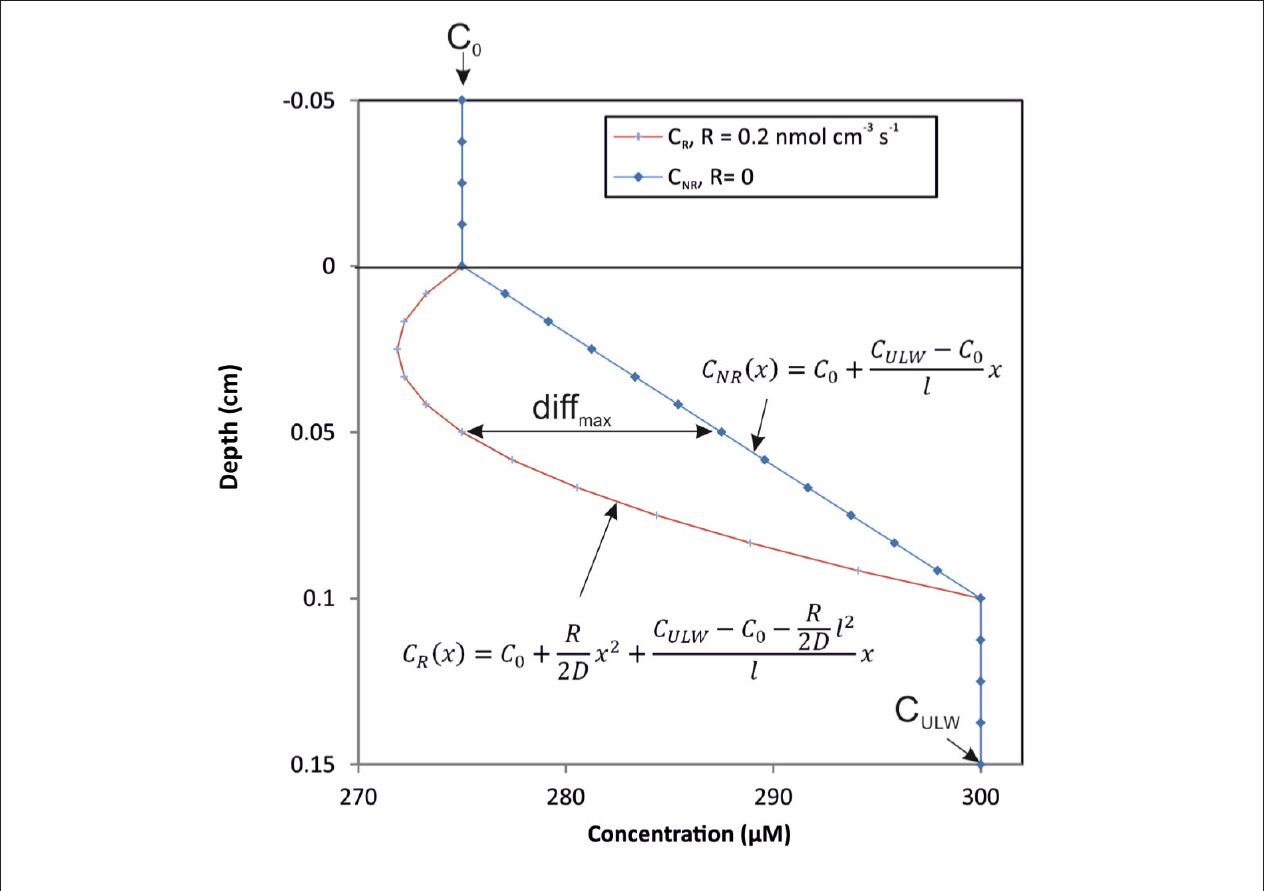
FIGURE 1 | Model of theoretical O 2 -profiles across the air-water interface. The two models indicate a gradient curvature at high reaction rate (red line) vs. a straight line gradient at a reaction rate equal to zero (blue line) and the maximum absolute difference (diff max ) between the two